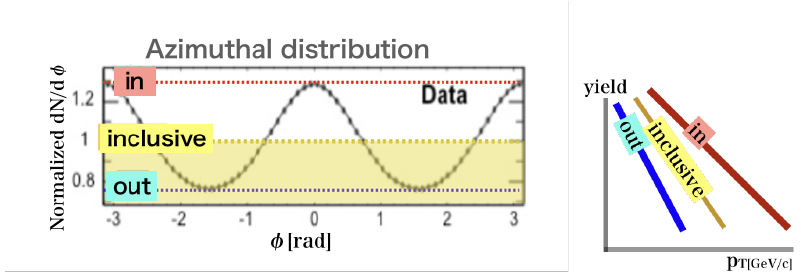
Figure 3. Left: A typical inclusive azimuthal anisotropic distribution. Right: Cartoon of the inclusive, in-plane and out-of-plane yields as a function of p T